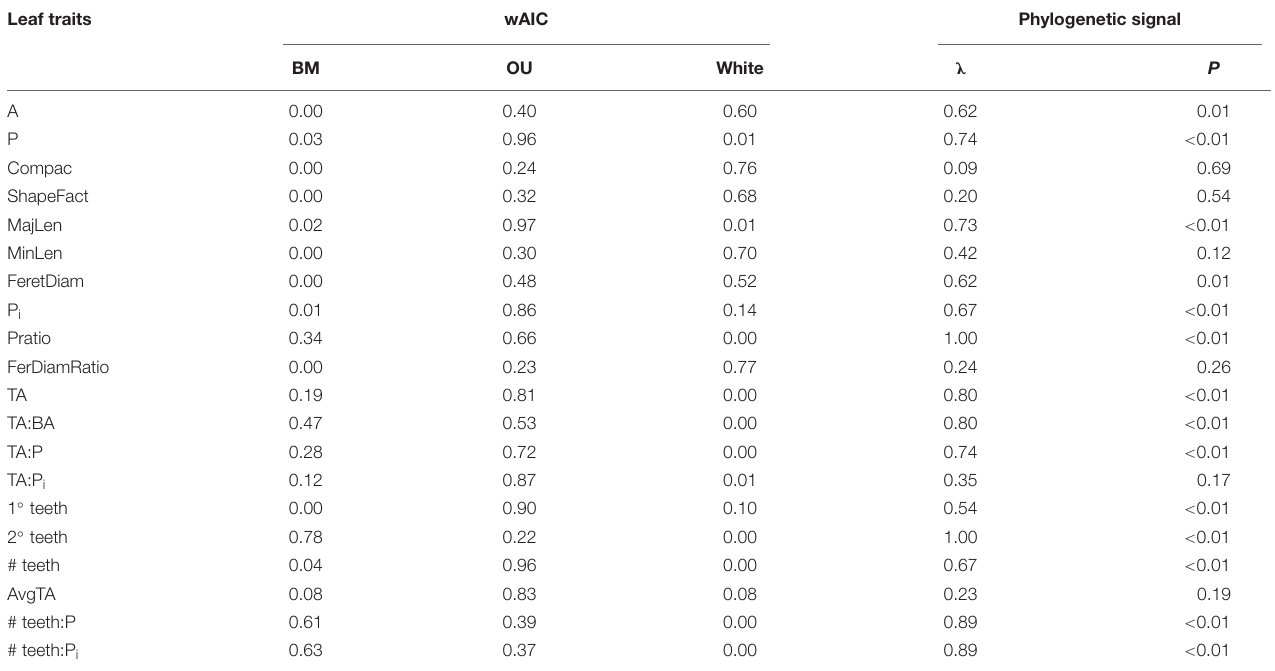
TABLE 2 | Results of Phylogenetic signal (Pagel’s lambda) and Weighted Akaike, based on exp( − 0.5 × (cid:49) AIC), to compare the best fit between a Brownian Motion (BM) model, an Ornstein-Uhlenbeck (OU) model and a White Noise (WN) null model of evolution. Leaf traits wAIC Phylogenetic